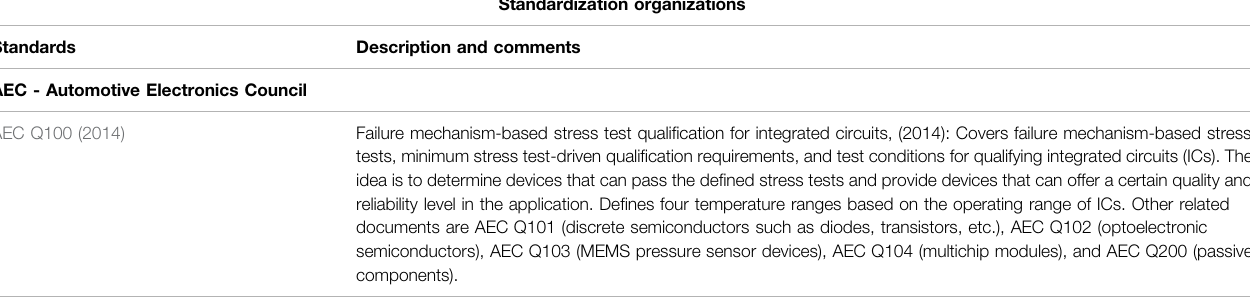
TABLE 1 | Overview of standards relevant to ECAS